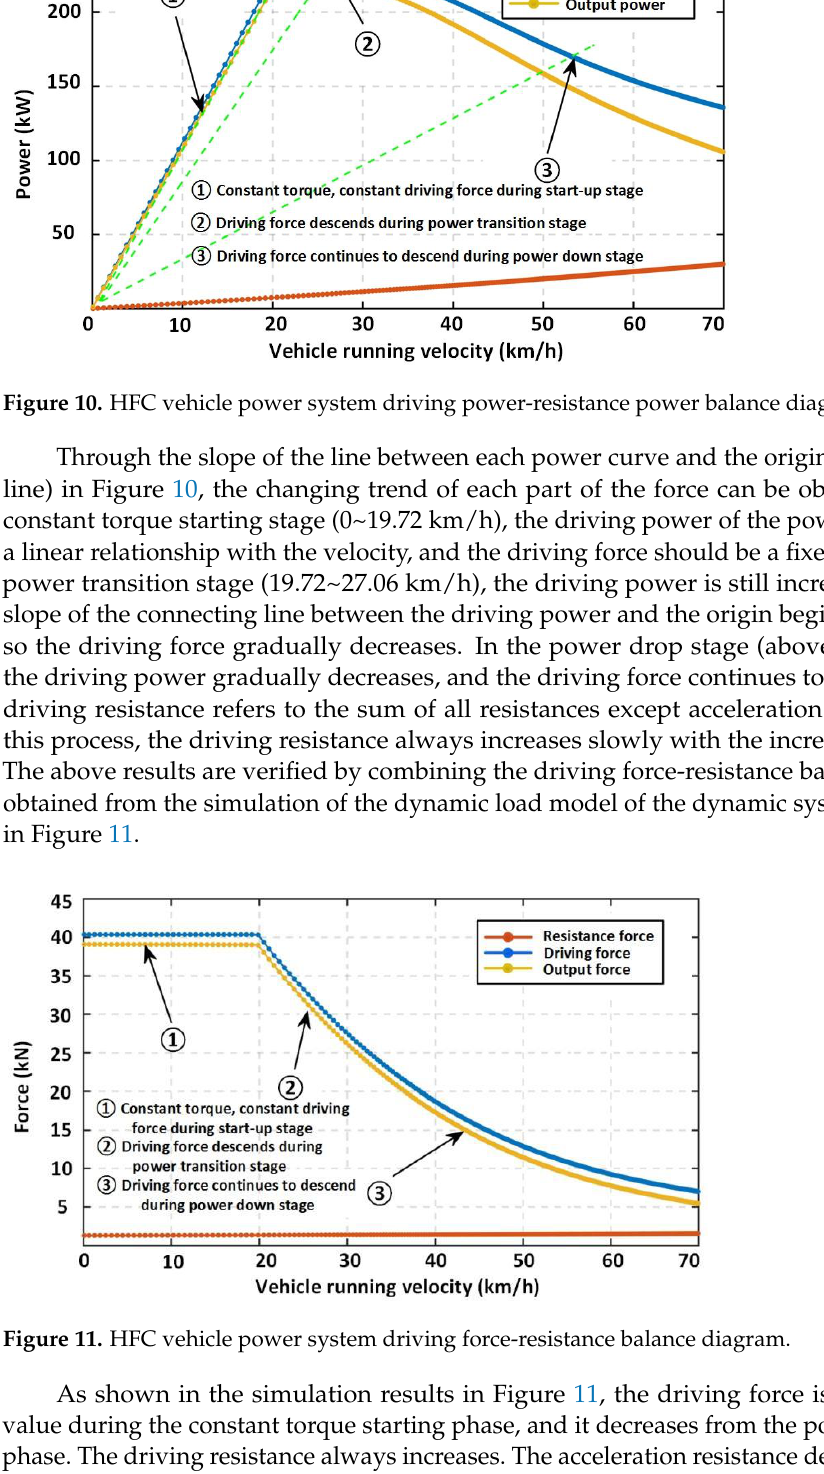
As shown in the simulation results in Figure 11, the driving force is at a constant value during the constant torque starting phase, and it decreases from the power transition phase. The driving resistance always increases. The acceleration resistance decreases slowly during the constant torque starting phase and appears from the power transition phase. The apparent decline is in line with expectations. The acceleration simulation result verification is shown in Figure 12.